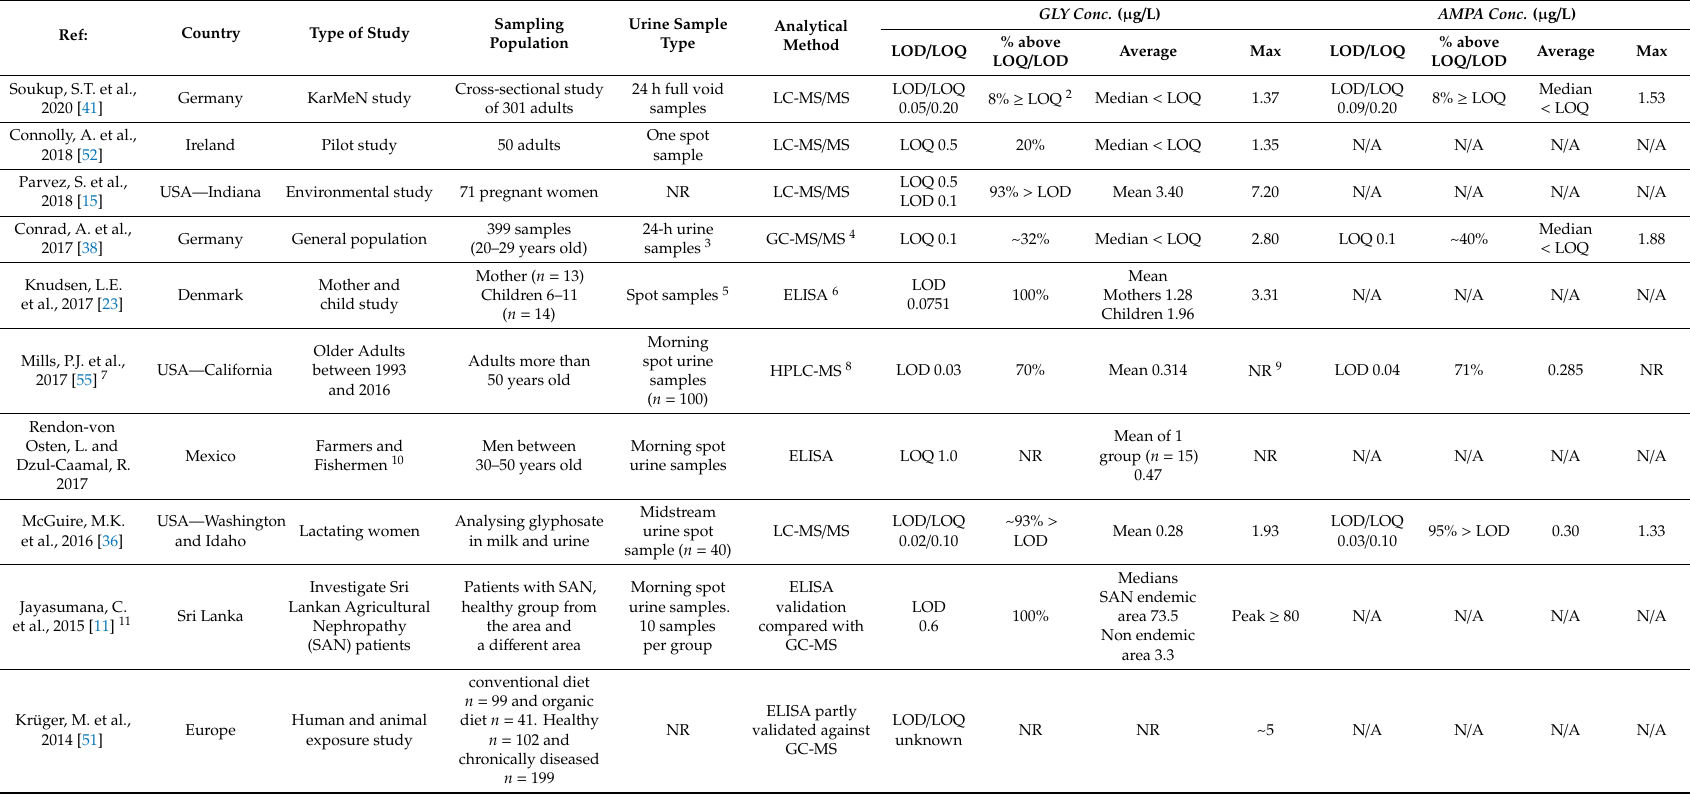
Table 2. Glyphosate (GLY) non-occupational exposure assessment studies employing biological monitoring methods via urine sampling from most recent publications 1 .